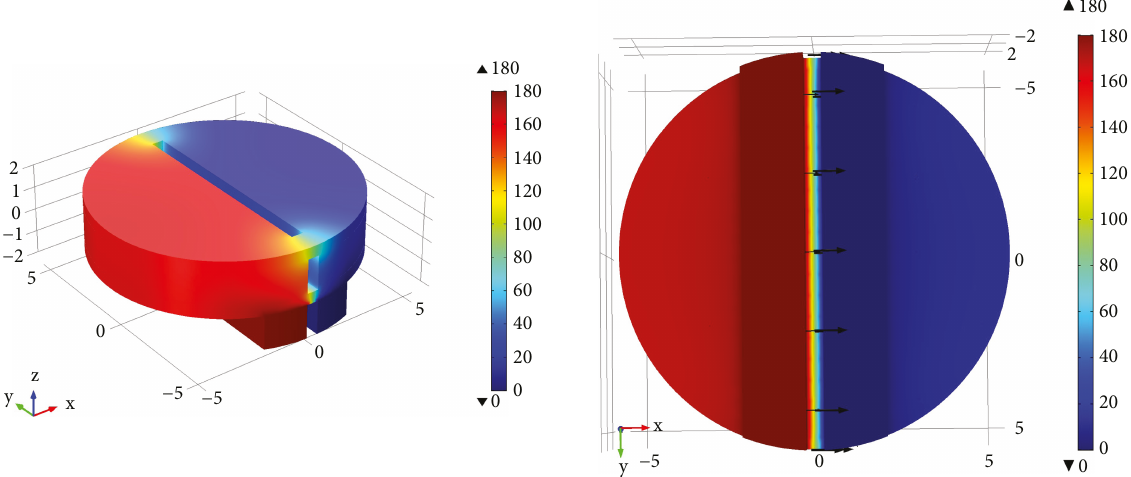
Figure 2: The distribution of collecting electrode potential and electric fi eld lines.